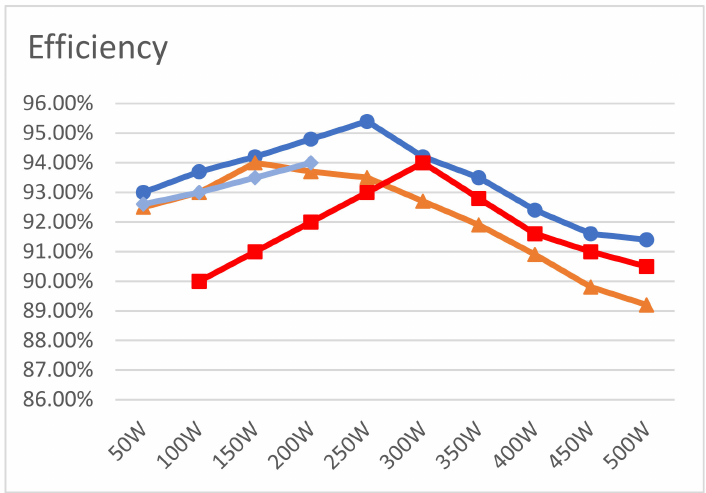
Figure 12. Comparison graph of the measured efficiency between the proposed converter and previous studies operated in the step-up mode ( proposed paper,